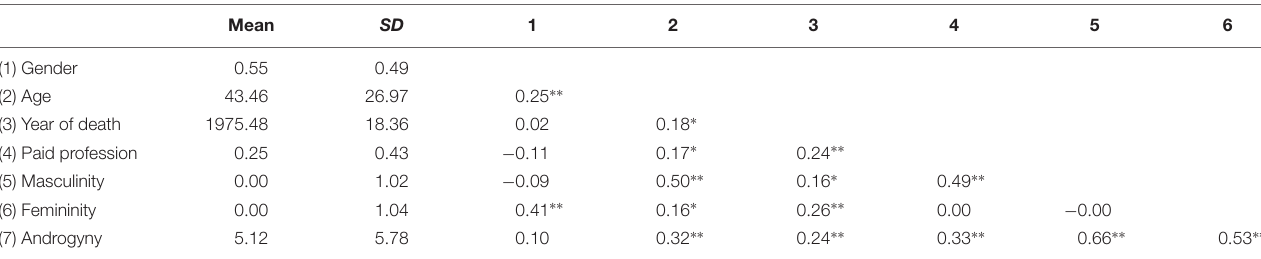
TABLE 2 | Means, standard deviations, and correlations for study variables.